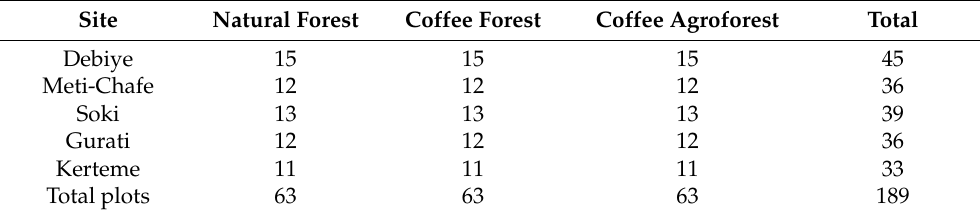
Table 1. Total number of study plots assessed within the natural forest, coffee forest and coffee agroforest during woody species assessment. The plot size (area per plot), tree and liana = 400 m 2 , sapling = 100 m 2 , seedling = 25 m 2